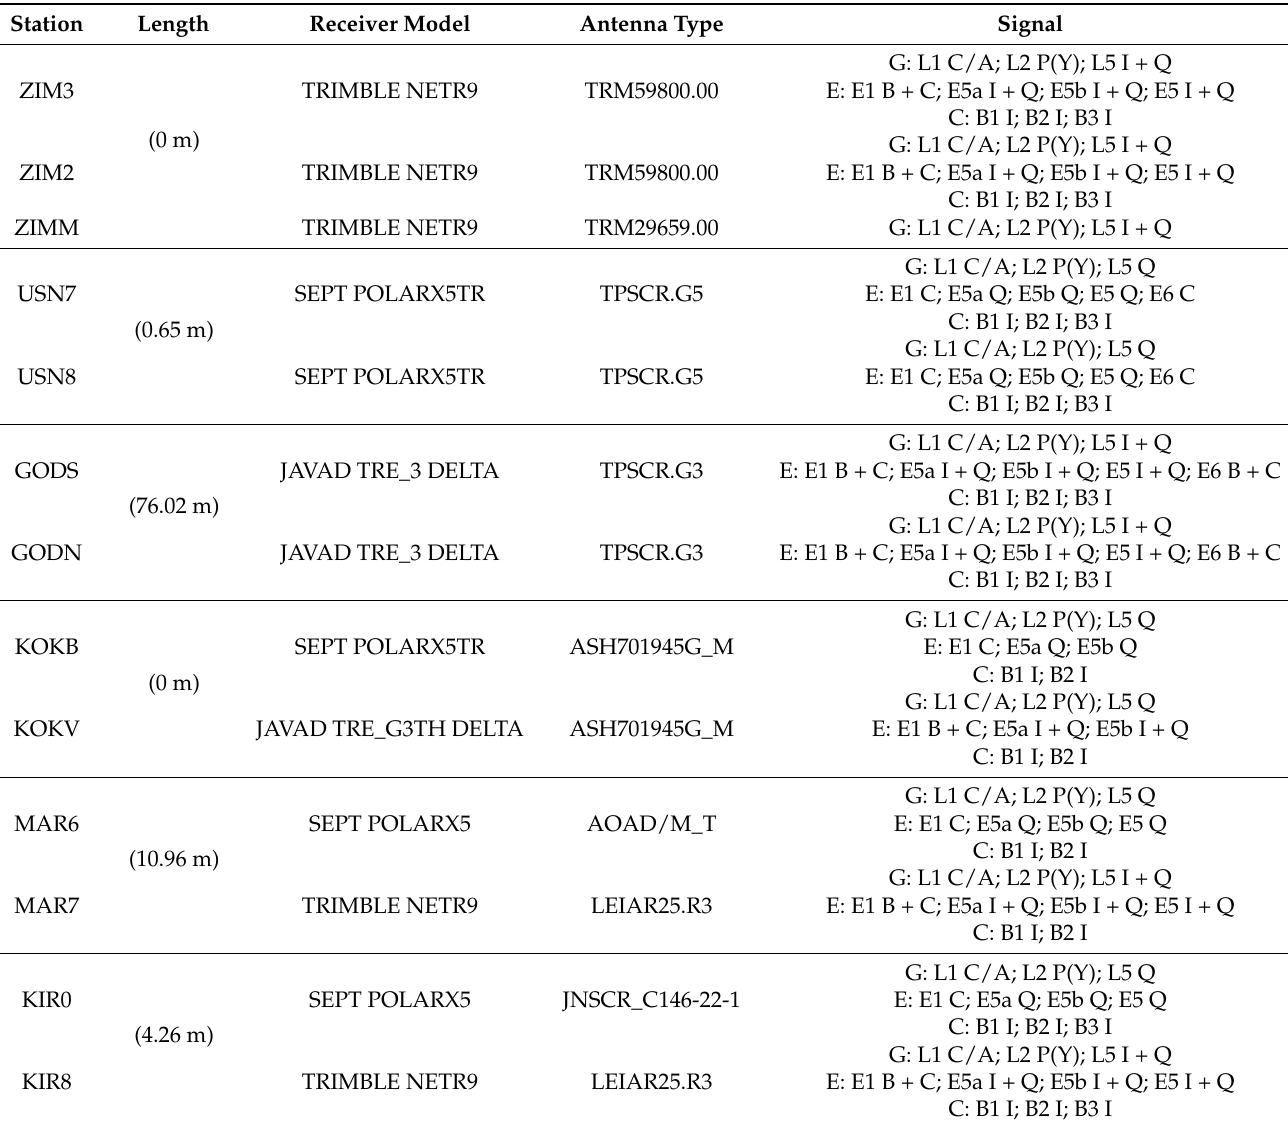
Table 1. Overview of stations. The signals listed in the table are limited to those used in the experiments, and the definition of signals corresponds to RINEX